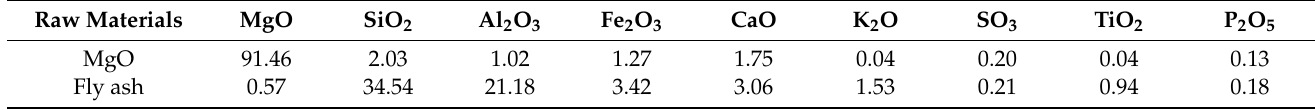
Table 1. Chemical composition of dead-burnt magnesia oxide and fly ash